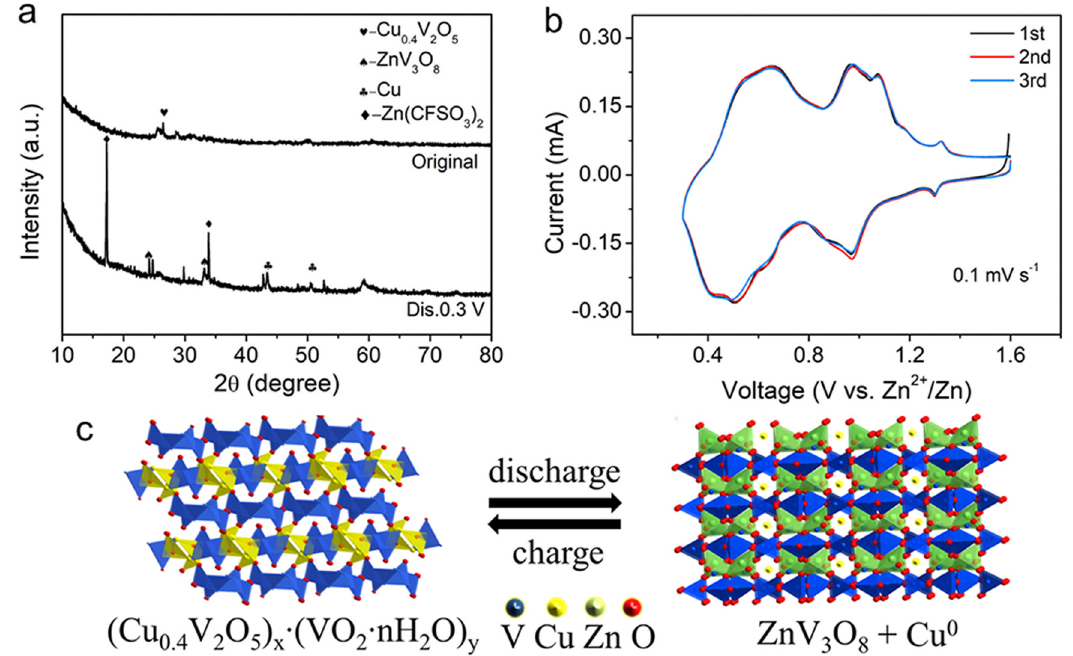
Figure 7: ( a ) The ex - situ XRD patterns of CVO - 2. ( b ) The CV curves of CVO - 2 at 0.1 mV s − 1 . ( c ) Schematic of reaction of ( Cu ) x ·( VO · n H ) y on discharging/charging progress at 0.1 A g − 1 0.4 V 2 O 5 2 2 O